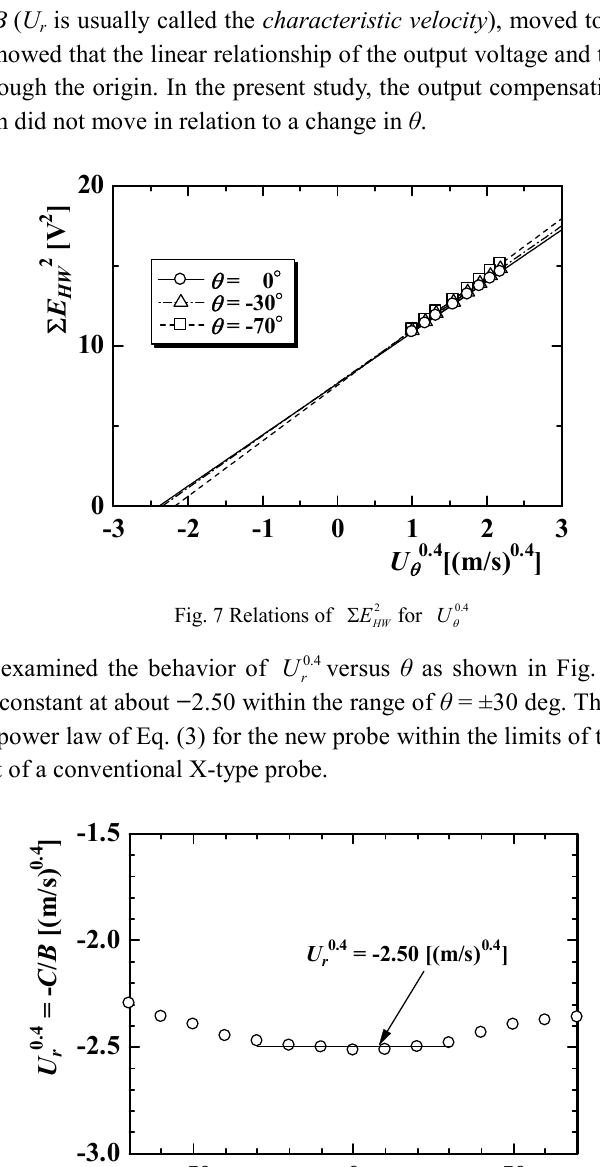
Fig. 8 Variation of 0.4